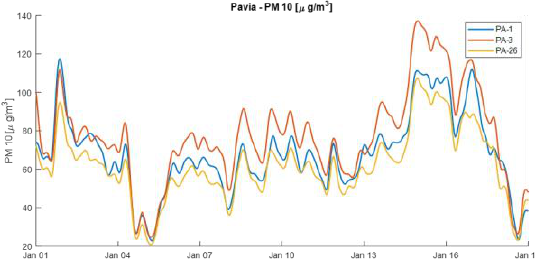
Figure 7. PM 10 for the first 20 days of January 2020 for the sensors PA-1, PA-3, PA-26